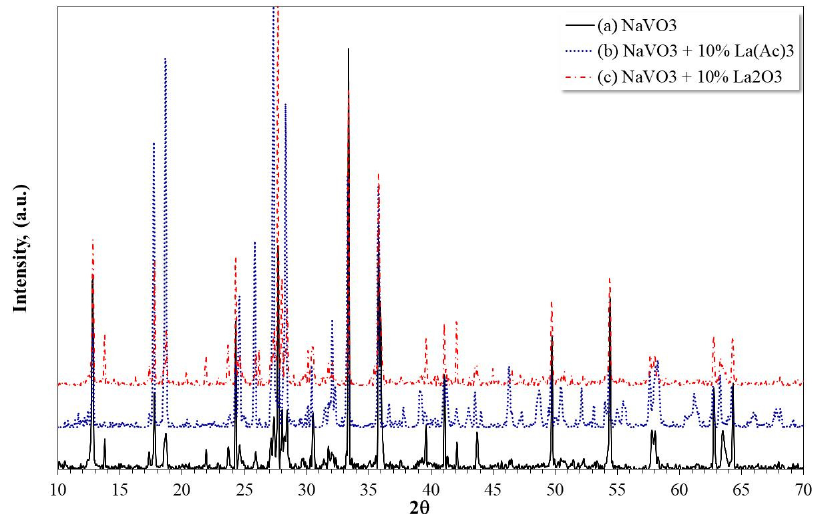
Figure 14. X-ray diffraction patterns of corrosion products formed on 304H steel corroded at 900 °C for 100 h in: ( a ) NaVO 3 , ( b ) NaVO 3 -10% La(Ac) 3 , and ( c ) NaVO 3 -10% La 2 O 3 .